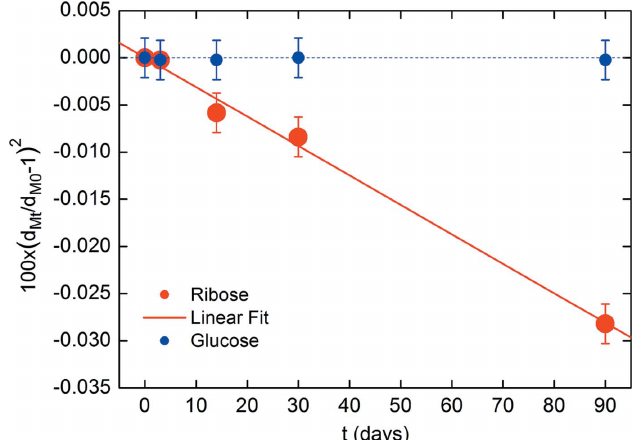
Figure 10 Squared relative variation of the meridional period d M at the incubation time t , denoted by d Mt , with respect to the value at t = 0, denoted by d M0 . The continuous red line is the linear fit of the ribose data (red), the horizontal dashed line is only reported as a guide for the glucose data